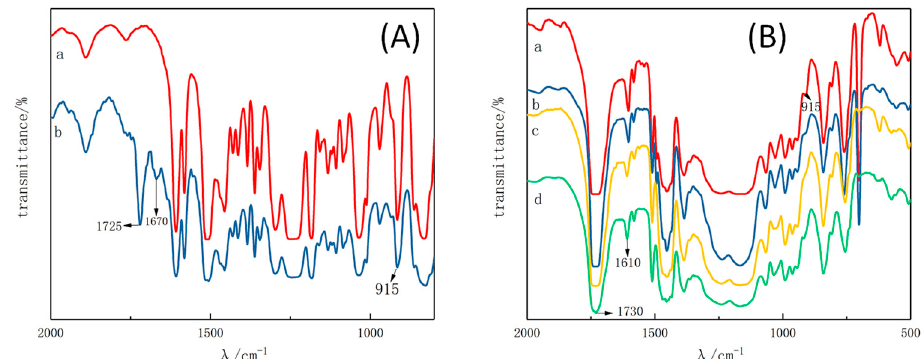
Figure 4. FTIR spectra from 500 to 2000 cm − 1 : ( A ) epoxy resin and modified epoxy resin (a: epoxy resin, and b: modified epoxy resin), and ( B ) waterborne epoxy ‐ styrene–acrylate composites (a: three ‐ layer core ‐ shell composite after polymerization, b: three ‐ layer core ‐ shell composite after 6 months, c: conventional core ‐ shell composite after 6 months, and d: conventional core ‐ shell composite after polymerization.).